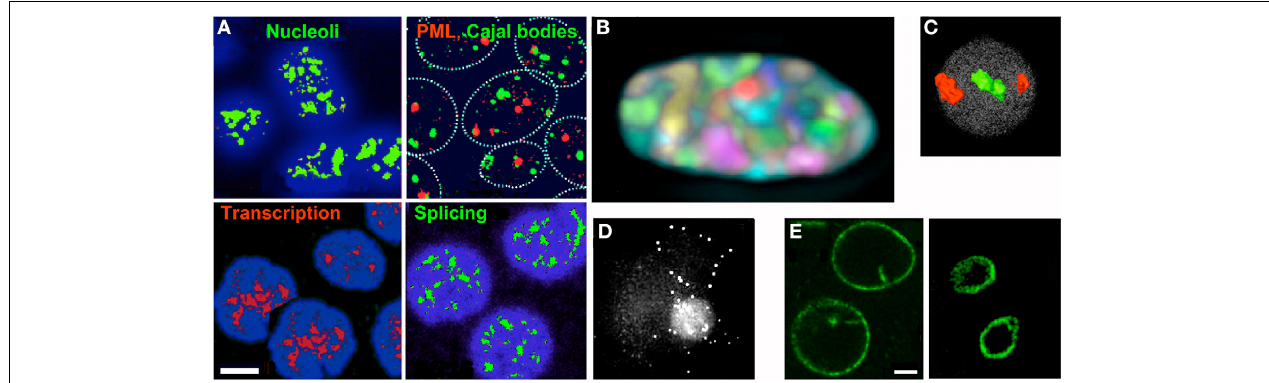
FIGURE 1 | (A–D) Features of the nucleus which can be understood as effects of crowding and entropic forces. (A) Compartments visualized by immunofluorescence (reproduced from [20]). (B) Discrete territories of the 24 chromosomesinahumanfibroblastnucleuslabeledwithdifferentfluorochrome combinations (reproduced from [21]). (C) Gene-poor chromosomes ([18], red) are located more peripherally than gene-rich chromosomes ([19], green) in the nucleus of human lymphocytes (reproduced from [22] by permission from